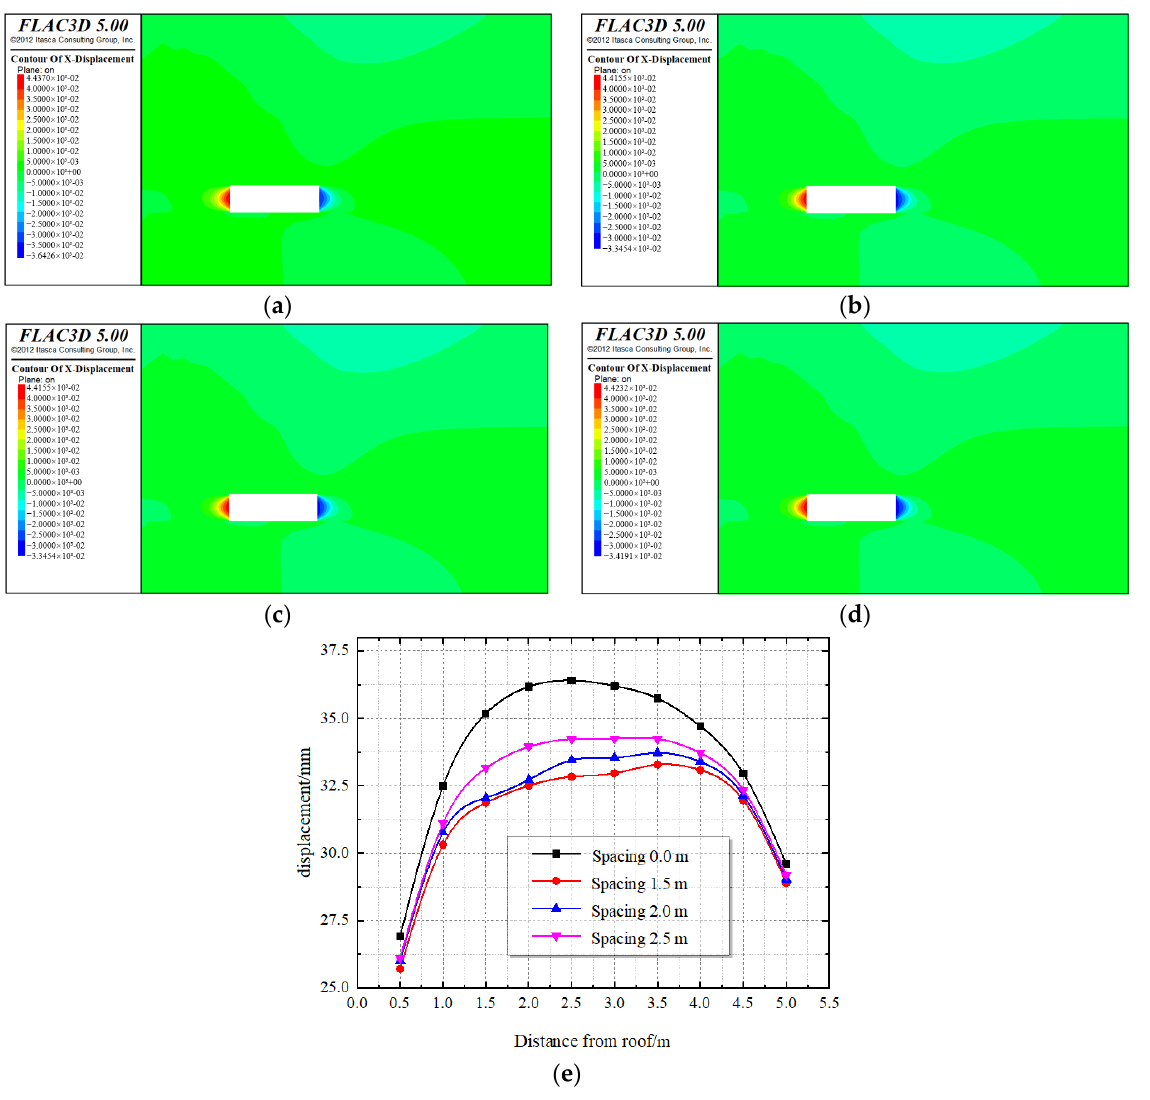
Figure 18. Horizontal displacement diagram of monitoring points with different spacings of the double-row grouting pipe: ( a ) no grouting pipe; ( b ) grouting pipe spacing is 1.5 m; ( c ) grouting pipe spacing is 2.0 m; ( d ) grouting pipe spacing is 2.5 m; ( e ) displacement line chart.